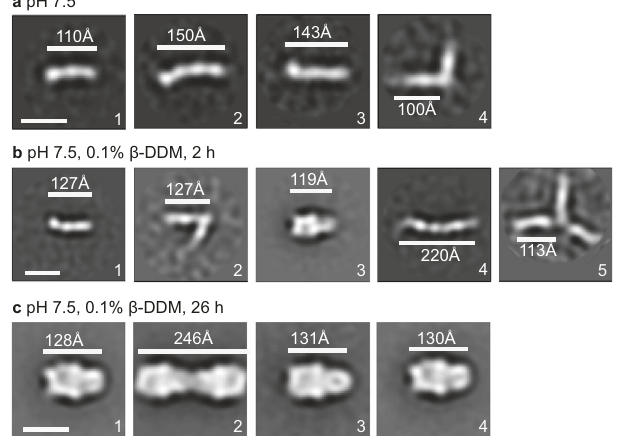
Fig. 6 β -DDM-dependent trimerization of Chlamy HAP2. a Representative negative-stain class averages of Chlamy HAP2 at pH 7.5 ( a ). b , c Representative negative-stain class averages of Chlamy HAP2 at pH 7.5 in the presence of β -DDM after 2h ( b ) and 26h ( c ) at 23°C. The length of particles (white lines) was measured. Scale bars of 10nm are shown in fi rst class average. Complete class averages are shown in Supplementary Fig. 4. The experiments of a – c were repeated twice with similar results.